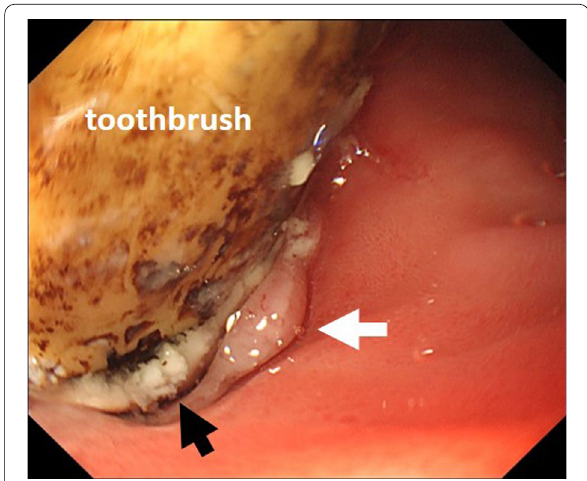
Fig. 2 The toothbrush was embedded in the second part of the duodenum (black arrow), and there was a granuloma (white arrow) around the handle part of the toothbrush at the duodenal bulb